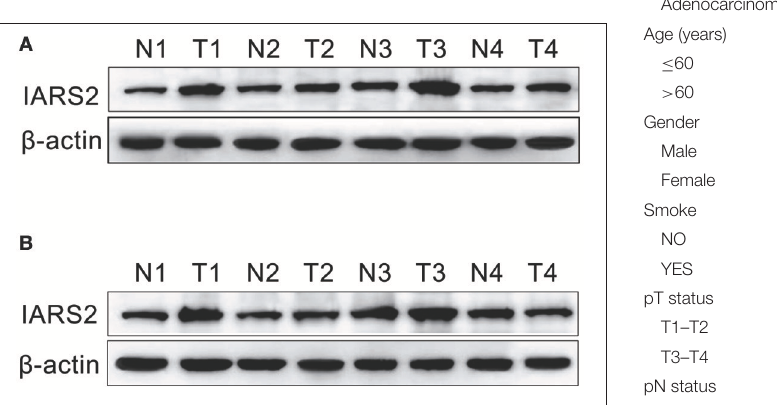
p-values represent Pearson χ 2 test. pT status, Tumor; pN status, Node. Bold values indicate P <